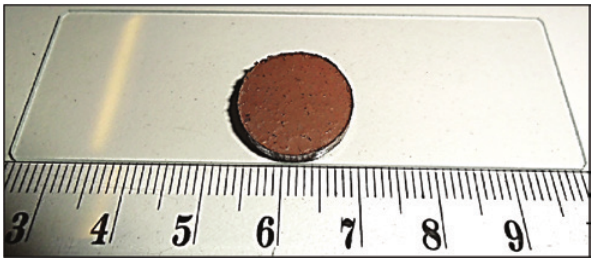
Fig. 2: Cylindrical compact of Mn 3 O 4 -HDPE